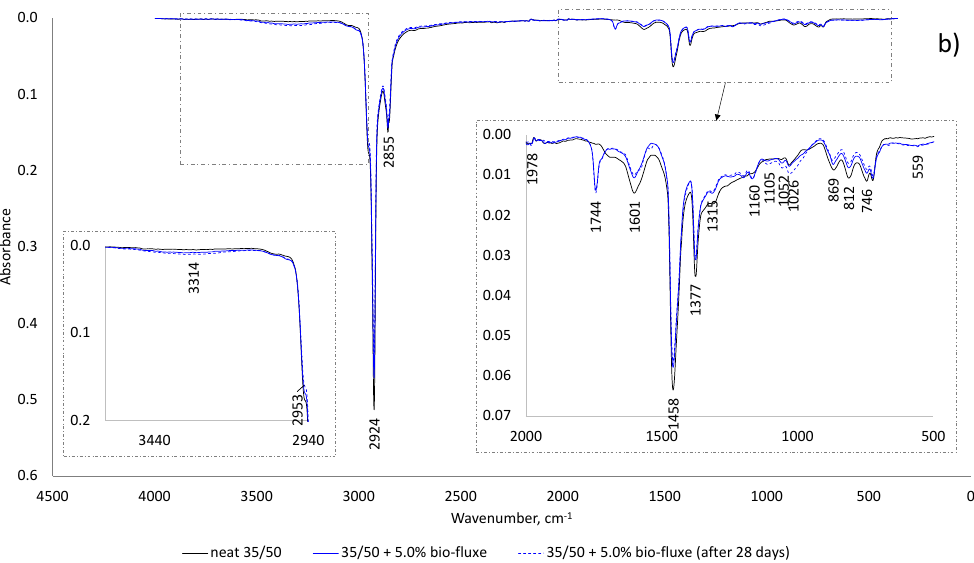
Figure 3. FTIR spectra of neat bitumen and fluxed bitumen by rapeseed oil methyl ester: ( a ) 70/100 bitumen; and ( b ) 35/50 bitumen.